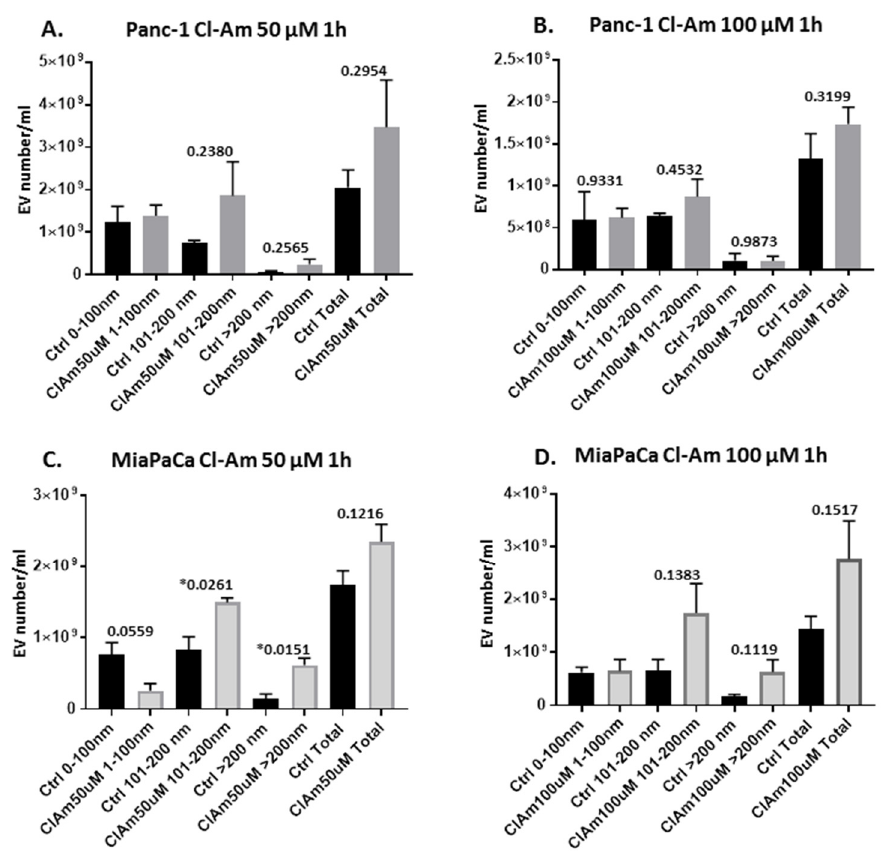
Figure 2. Pan-PAD inhibitor (Cl-amidine) treatment shows varying effects on the two pancreatic ductal adenocarcinoma (PDAC) cell lines under study with respect to cellular extracellular vesicle (EV) release. ( A ) Effects of Cl-amidine (50 µ m 1 h treatment) on EV release from Panc-1 cells. ( B ) Effects of Cl-amidine (100 µ m 1 h treatment) on EV release from Panc-1 cells. ( C ) Effects of Cl-amidine (50 µ m 1 h treatment) on EV release from MiaPaCa-2 cells. ( D ) Effects of Cl-amidine (100 µ m 1 h treatment) on EV release from MiaPaCa-2 cells. For each set of histograms, Cl-amidine (50 or 100 µ m)-treated and control (PBS)-treated cells were run under the same experimental conditions, respectively. Exact p -values are indicated ( * highlights significance at p ≤ 0.05), error bars show SD; n = 3 biological replicates for all).